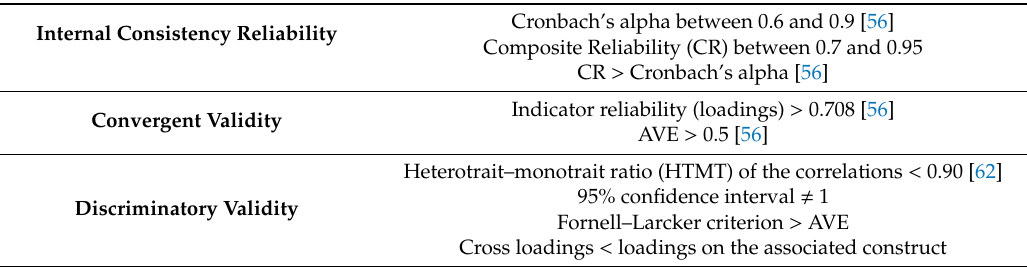
Table 1. Cut-o ff levels of the quality criteria of the reflective measurement models [56]. AVE = average variance